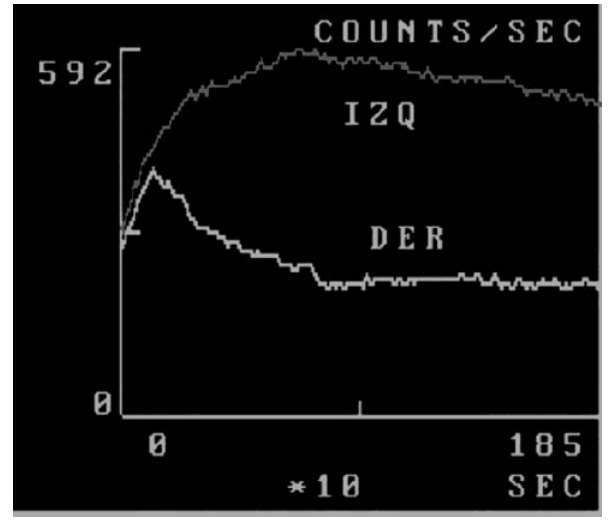
Figure 6. Prolonged left nephrogram with delayed peak activity.